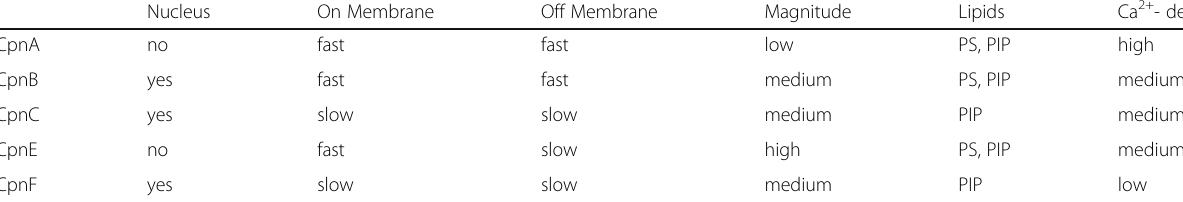
Table 1 Summary of membrane binding properties of Dictyostelium copines